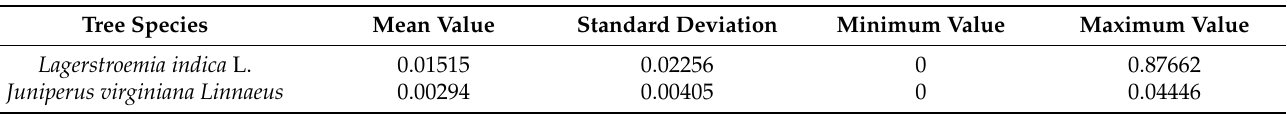
Figure 17. The variation of volumetric ice content and the ice freeze-thaw rate of the branches of Juniperus virginiana Linnaeus . Table 3. The statistical analysis of the volatility of the ice freeze-thaw rate of the branch volume ice content during the overwintering